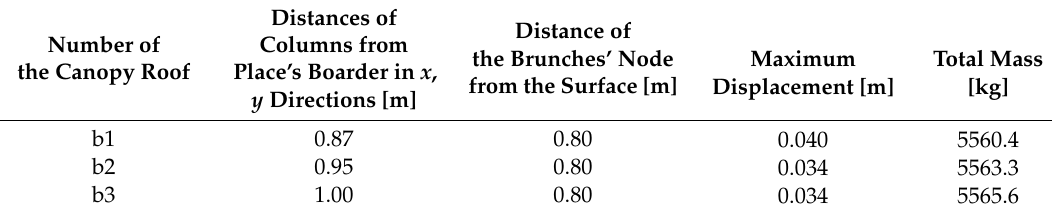
Table 3. The results of the simulation assuming bar lengths within the scope 1.5–2.0 m.